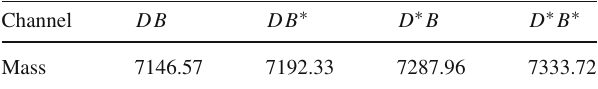
Table 2 Masses [MeV] of the isospin-averaged D ( ∗ ) B ( ∗ ) thresholds,